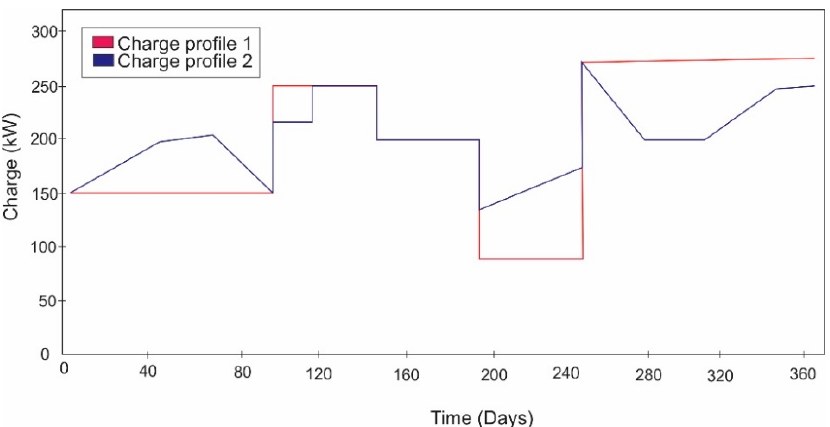
Figure 7. The proposed syystem charge profiles.